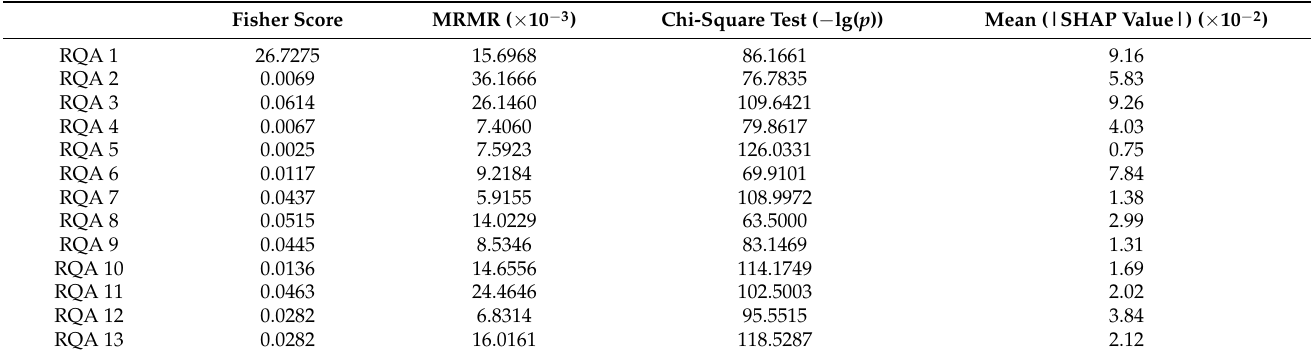
Table 8. The calculated results of 13 RQA features based on four feature ranking algorithms.